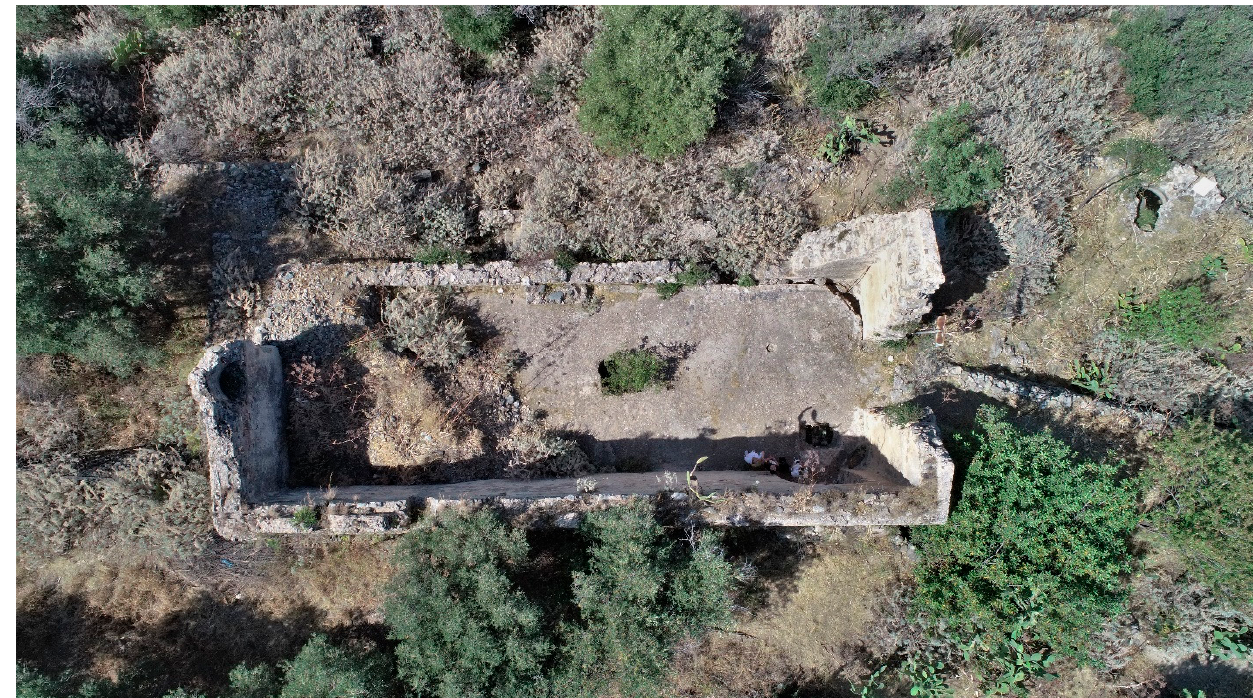
Figure 6. The Church of San Basilio: ( a ) Ruins of the main façade; ( b ) Aerial view from the west.